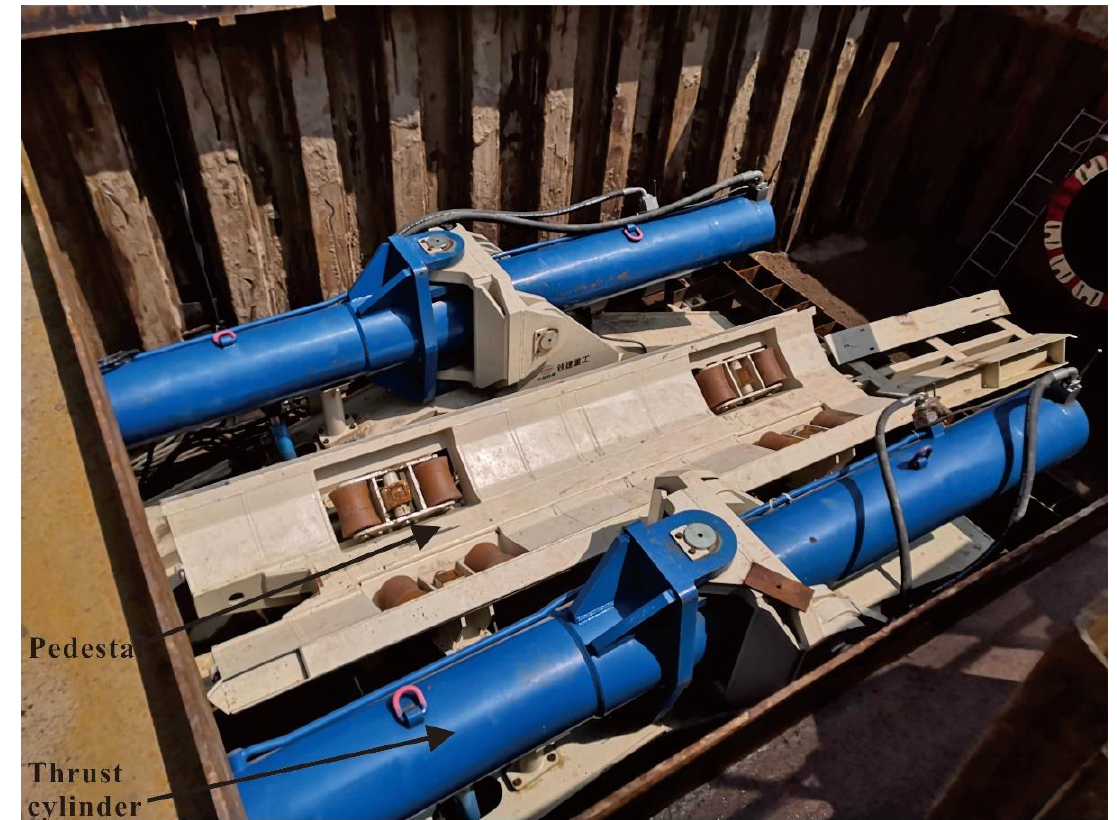
Figure 10. The pedestal of the thrust machine.